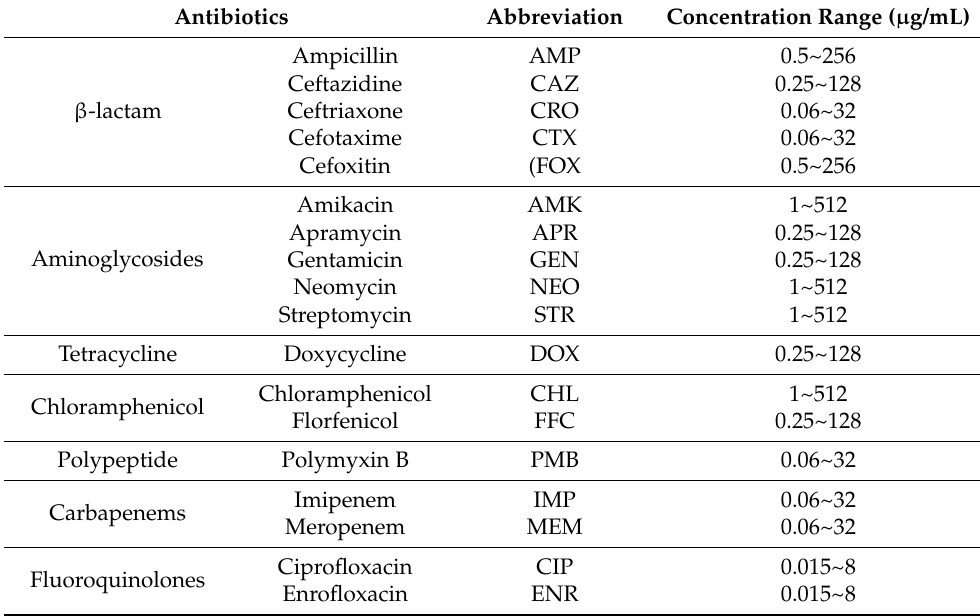
Table 1. Antimicrobials and the range of concentrations